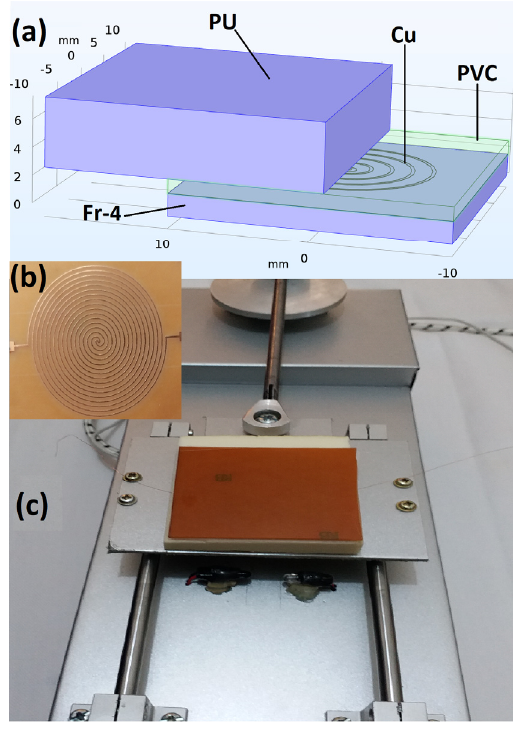
Figure 1. (a) Schematic of the planner spiral TENG; (b) spiral electrode; (c) fabricated instrument for applying mechanical sliding